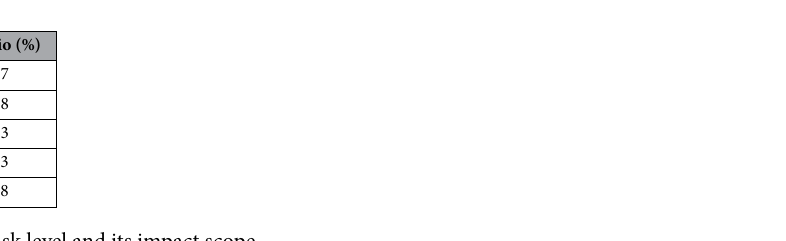
Table 5. Flood disaster risk level and its impact